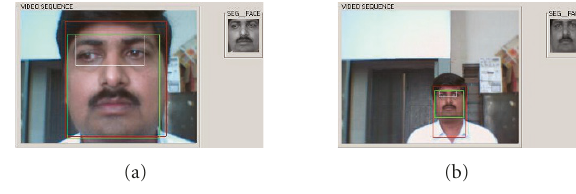
Figure 13: Largest and smallest face images segmented by the pro- posed method.